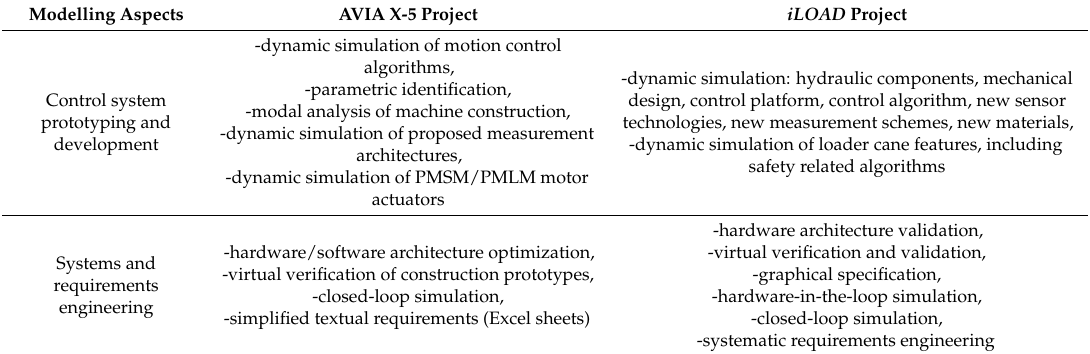
Table 1. Modelling